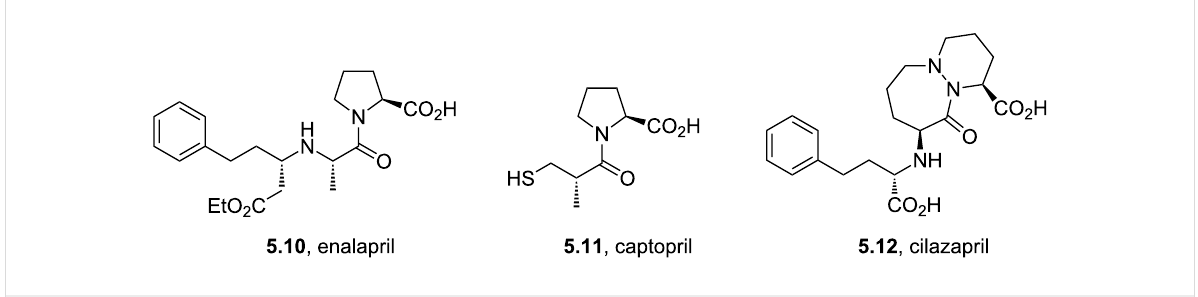
Figure 15: Structures of captopril, enalapril and cilazapril.